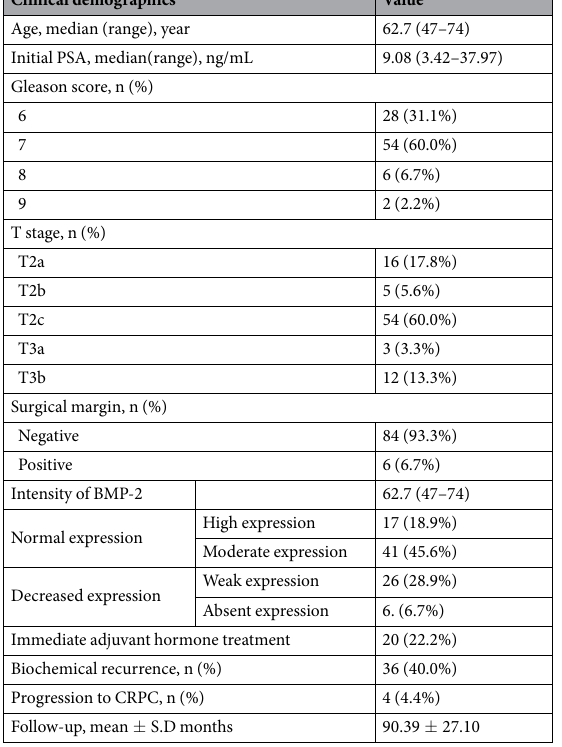
Table 1. Clinical demographics of patients with prostate cancer ( n = 90). PSA = prostate specific antigen; BMP = bone morphogenetic proteins; S.D = standard deviation; CRPC = castration resistance prostate cancer.